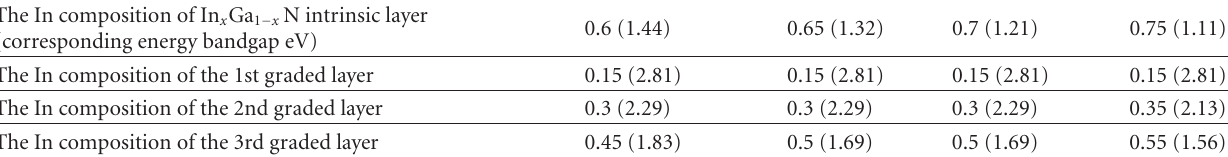
Table 3: The optimum In-composited combination of three graded layers for each In composition of In x Ga 1 − x N pin solar cells. The In composition of In x Ga 1 − x N intrinsic layer (corresponding energy bandgap